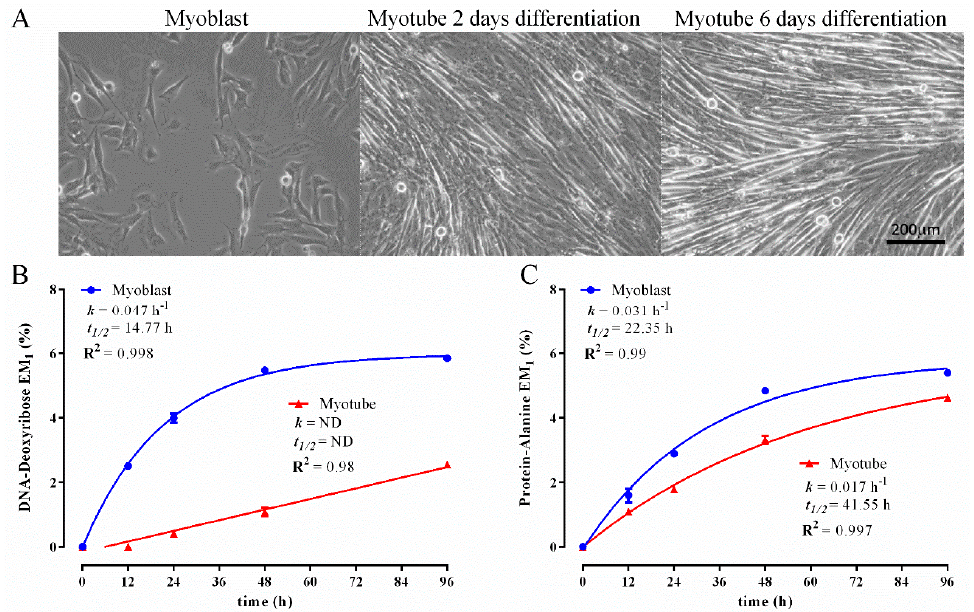
Figure 3. Comparison of 2 H-incorporation into DNA-derived deoxyribose and protein-derived alanine in C2C12 myoblasts and myotubes following incubation in 4% 2 H 2 O treatment over 96 h. Representative images of myoblast and differentiating myotubes ( A ); excess molar enrichment in the M 1 isotopomer (EM 1 ) over time in DNA-derived deoxyribose ( B ) and protein-derived alanine ( C ) in myoblasts and myotubes. Inset: fractional synthesis rate constant ( k ), half-life ( t 1/2 ) and goodness-of-fit (R 2 ) from non-linear curve fitting. Two replicates were performed for each time point. Error bars represent the standard error of the mean